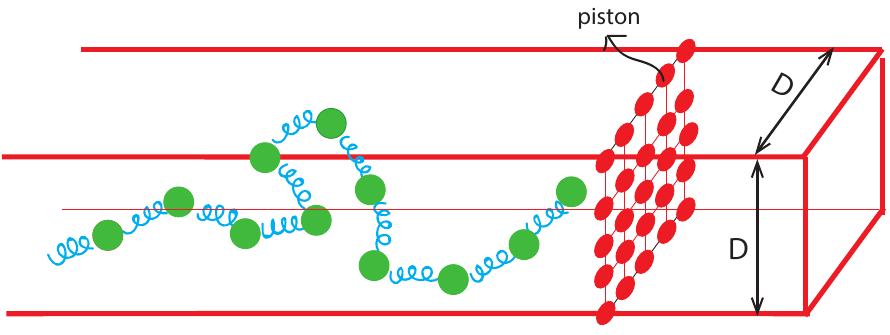
Figure 1. A bead-spring model of semi-flexible chain confined inside a nanochannel of width D being pushed by a sliding gasket piston (nano-dozer). The green beads are connected via anharmonic spring potentials and interact at long-range via excluded-volume. The red wall particles are at a fixed distance from each other on a square lattice and move together at the piston velocity. The chain always remains confined inside the